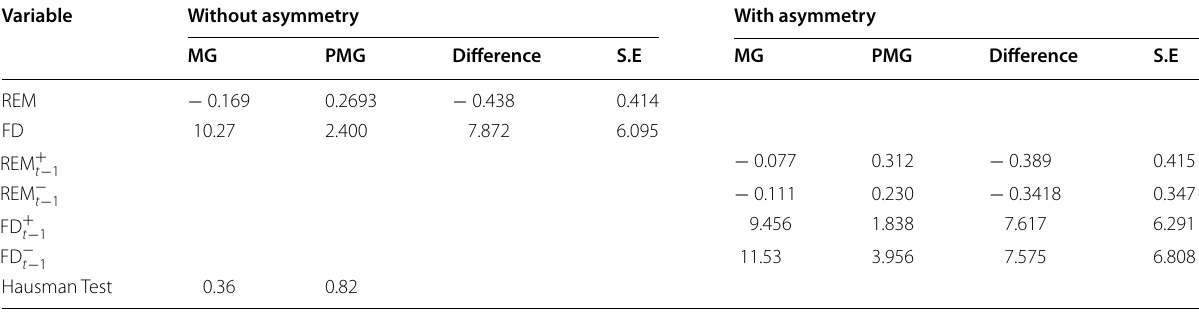
Table 2 Hausman MG PMG, Sigmamore Variable Without